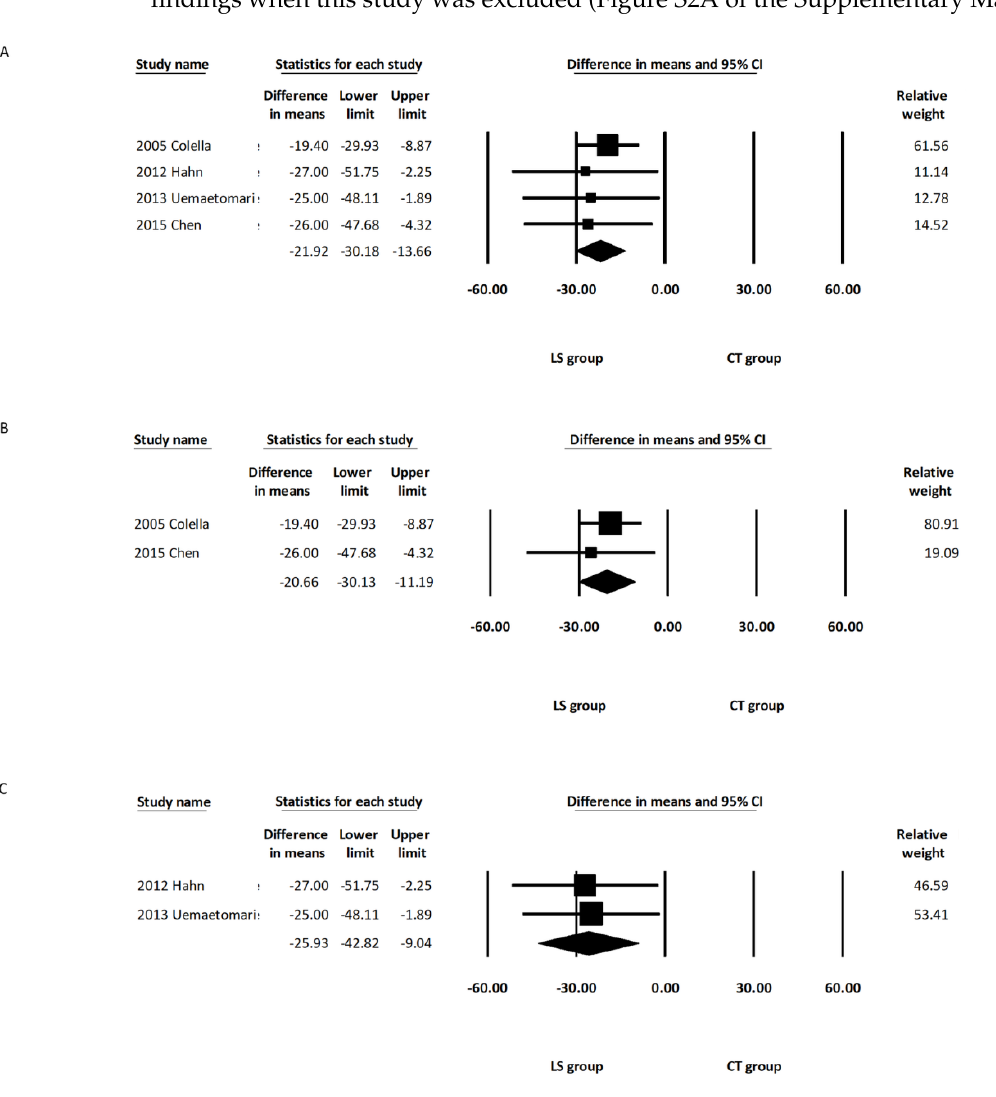
Figure 2. Forest plot of the operative duration during parotidectomy. ( A ) Overall study group. ( B ) Studies including only the LSP device. ( C ) Studies including only the LSJ device. LS, LigaSure; LSP, LigaSure Precise; LSJ, LigaSure Small Jaw; CT, conventional technique; CI confidence